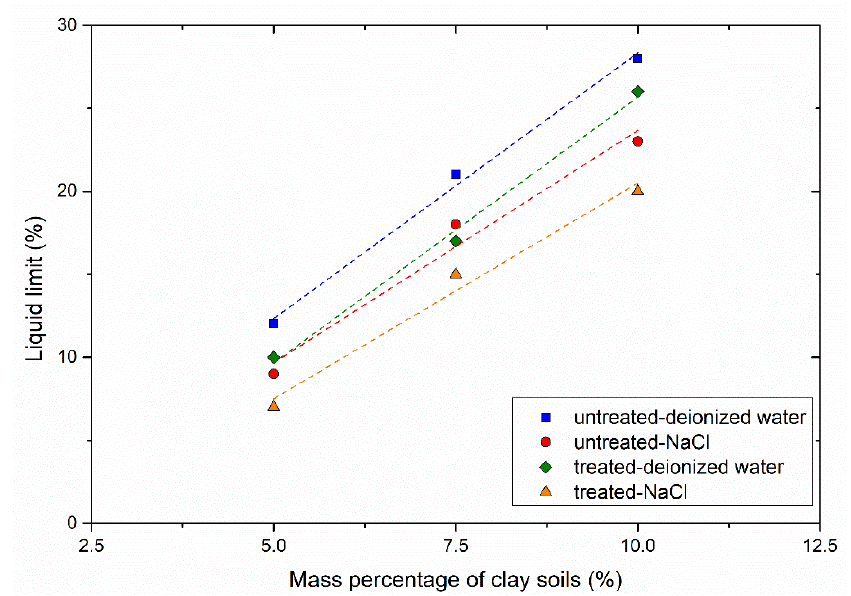
Figure 5. Liquid limit of samples: treated with the premixing method.